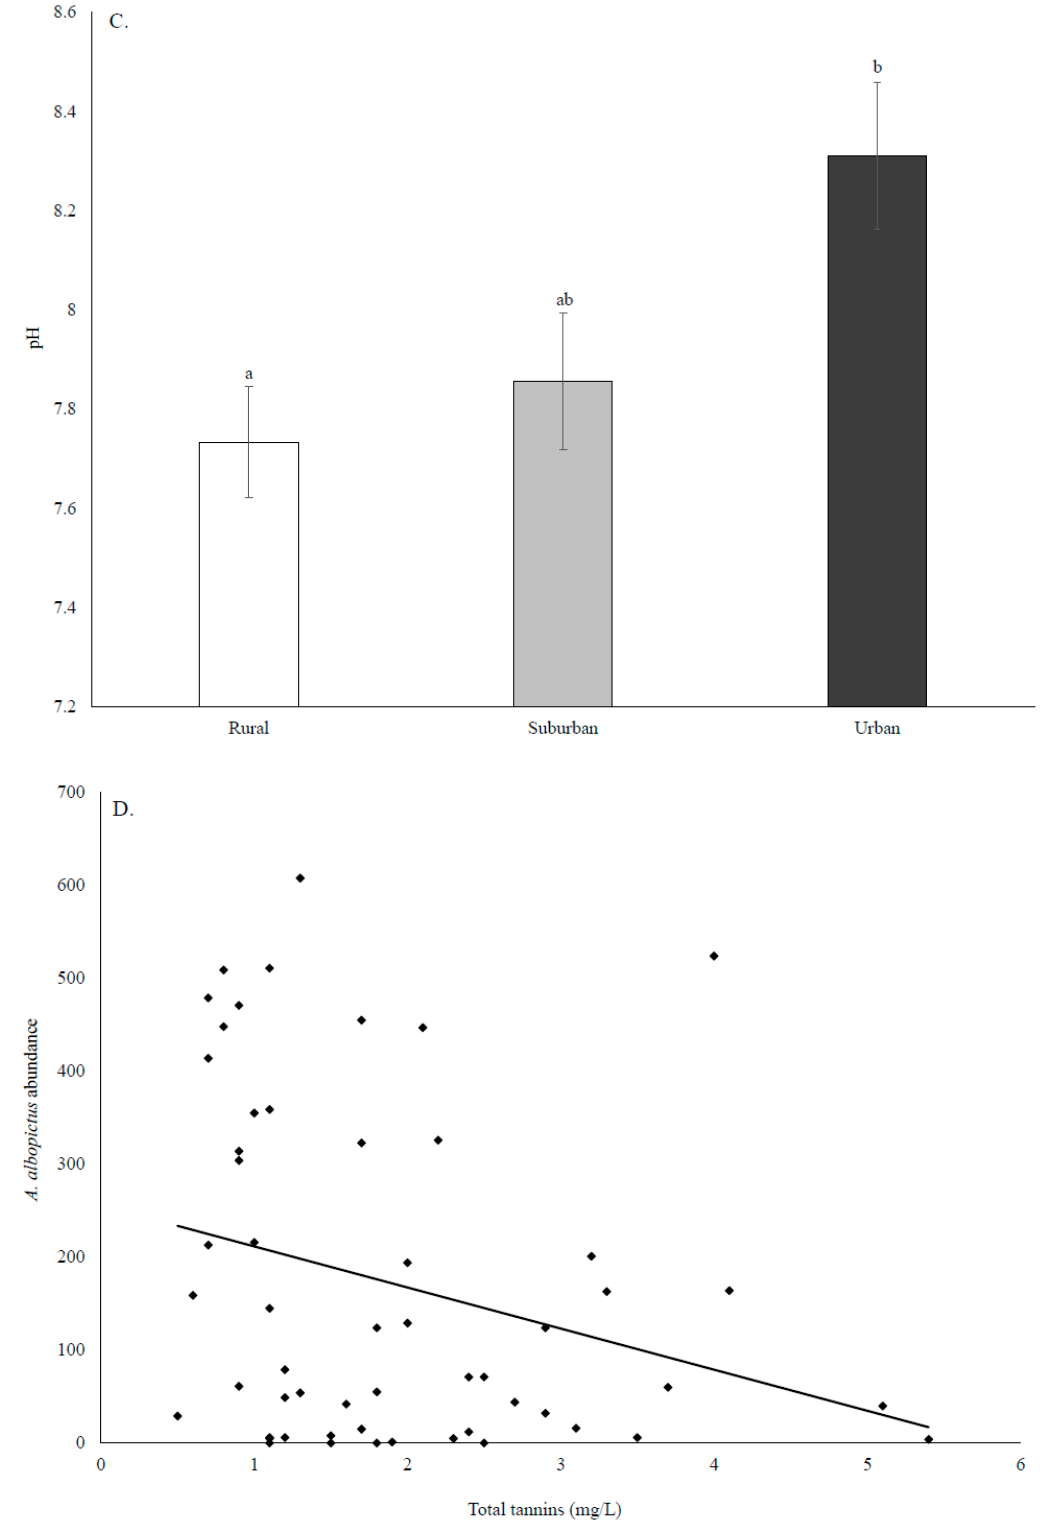
Figure 3. Water chemistry measured at a single time point at the end of the sampling period in September 2017. ( A ) Total nitrogen, ( B ) total tannins, ( C ) pH, and ( D ) the negative relationship between the total A. albopictus collected from a cup and the total tannins measured from that cup. Different lower case letters above bars indicate groups that are significantly different from each other.